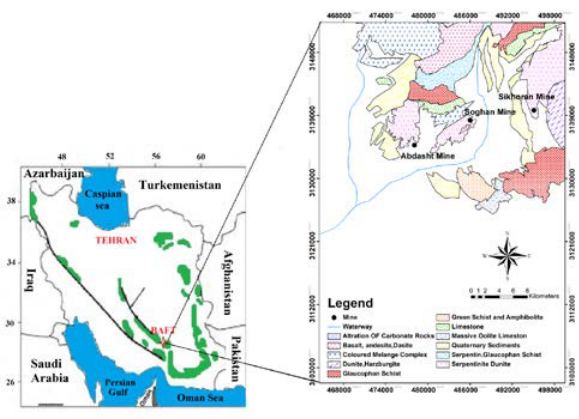
Figure 1. Overview of ophiolite complexes (green part) in Iran, and geology map of the study area.